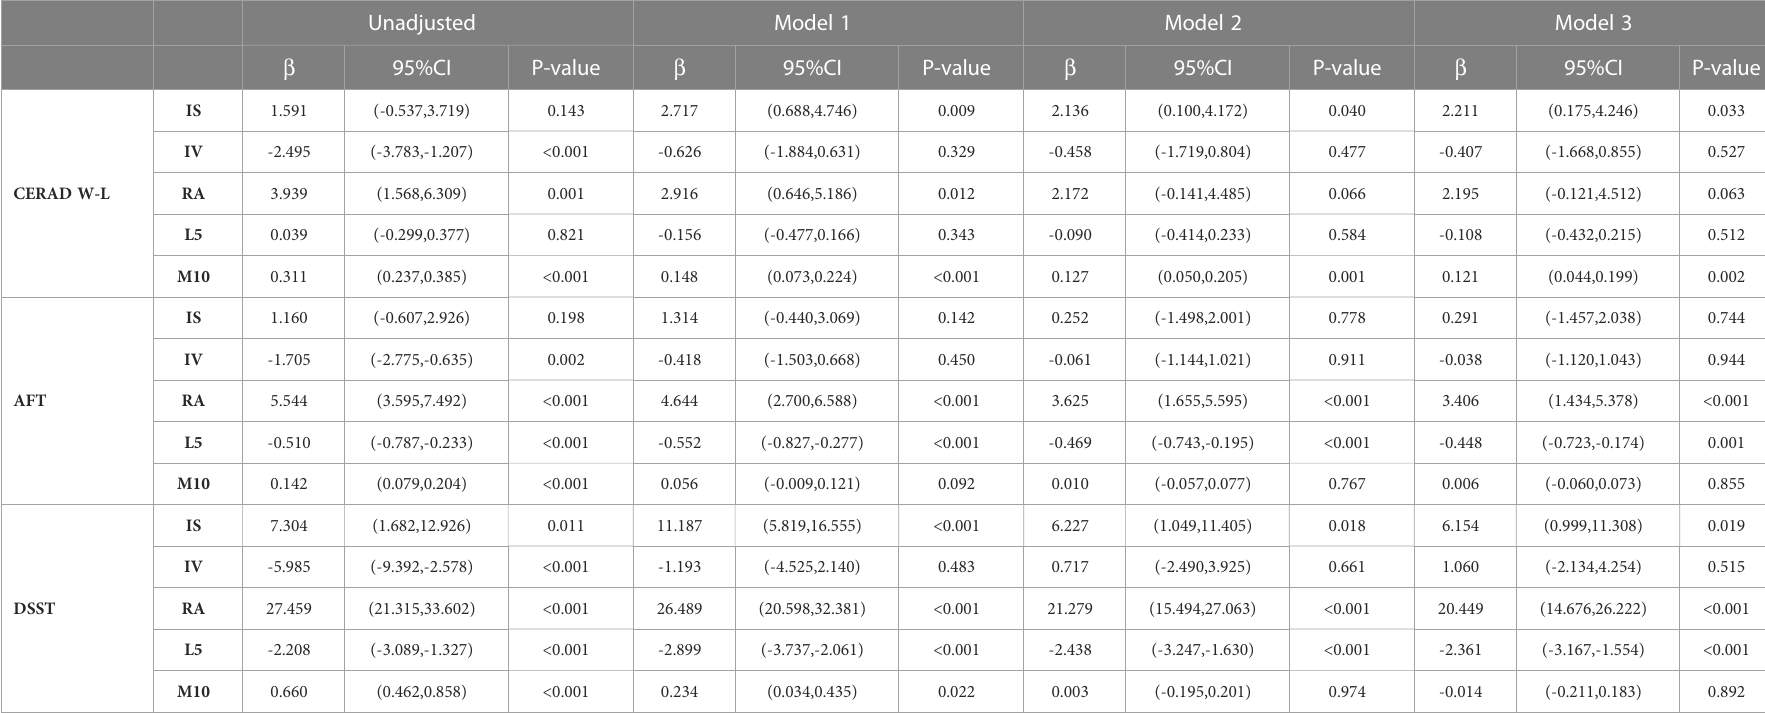
TABLE 2 Associations of RAR parameters with cognitive function among all adults age ≥ 60 years, NHANES 2011 –